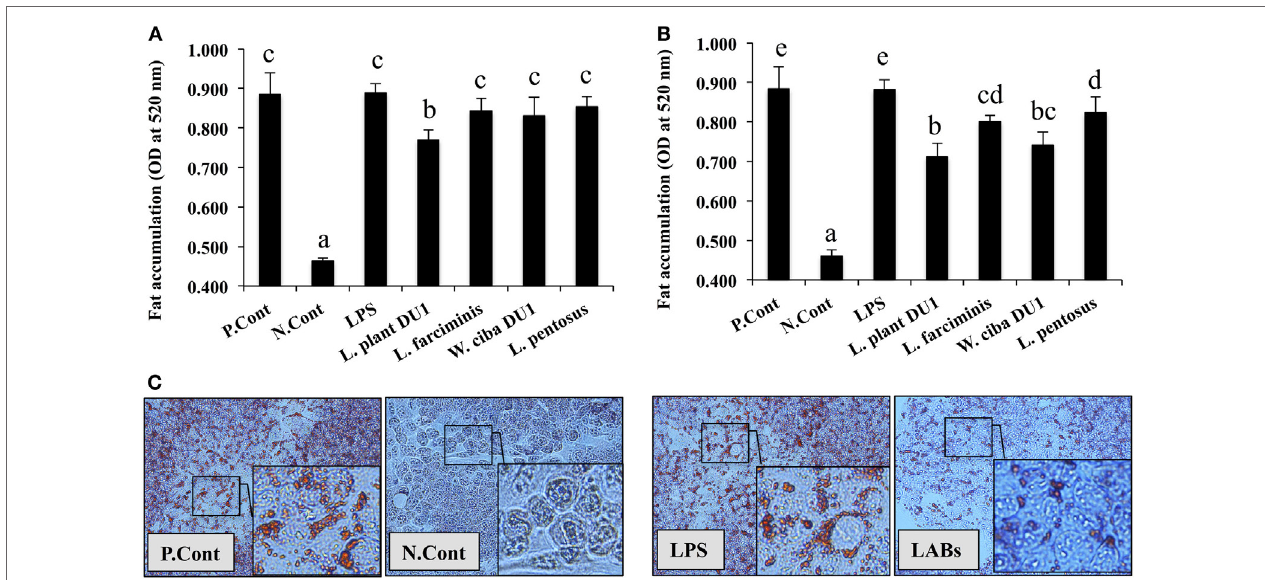
FigUre 1 | Total cellular fluid (TCF) of lactic acid bacteria (LAB) reduced accumulation of lipid in HepG2 cells. Confluence HepG2 cells were separately incubated with 25 µl (a) and 50 µl (B) of TCF of LAB strains and LPS (alone) for 48 h, after treated with free fatty acid (FFA) (1 mM) for 24 h. (c) Photographic pictures of HepG2 cells with lipid droplets. The amount of lipid accumulated in the treated cells was quantified by spectrophotometer at 520 nm, after ORO staining. The results presented as an average values (mean ± SD) of three independent experiments. Different superscript letters indicate significant differences at the 0.05 level. P. Cont and N. Cont are the short form of positive control (FFA alone treated) and negative control (normal